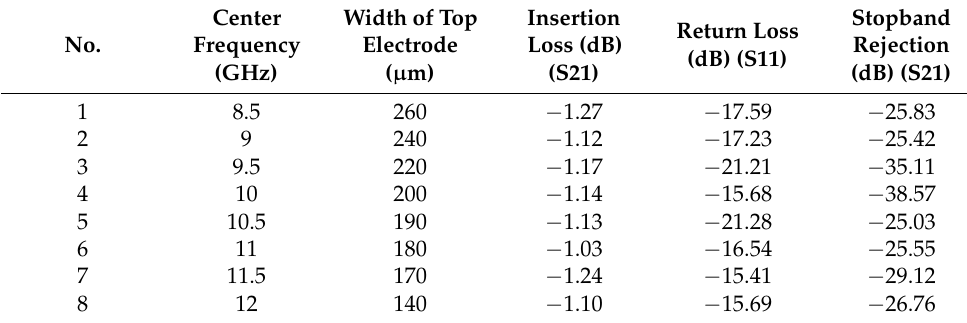
Table 2. The list of the S parameters of MEMS filter.